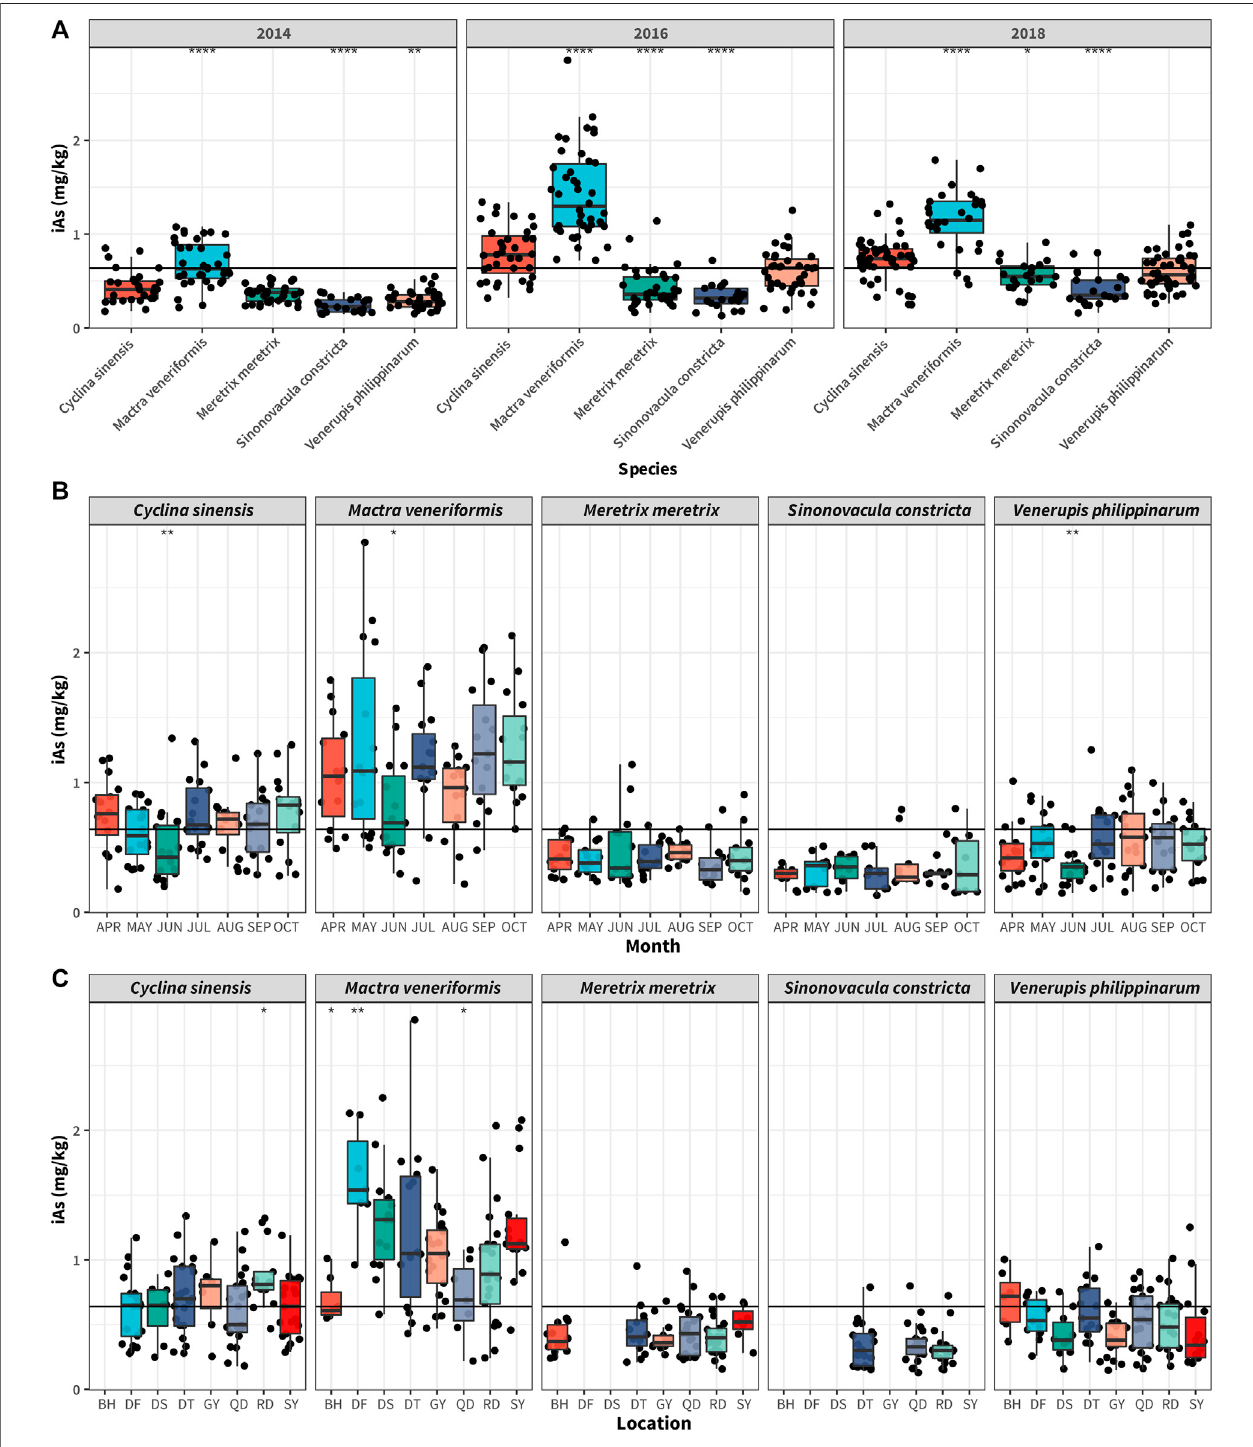
FIGURE4| InorganicAsconcentrationsindifferentclamspecies (A) ,collectingmonths (B) ,andsamplinglocations (C) inJiangsuprovince,China.Thebottomand top of the boxes represent the 25th and 75th percentiles, while error bars represent the 5th and 95th percentiles. The solid lines inside the box represent the median iAs concentrations. In all panels, data were analyzed using one-way analysis of variance (ANOVA), where * p < 0.05; ** p < 0.01; ****p < 0.0001.